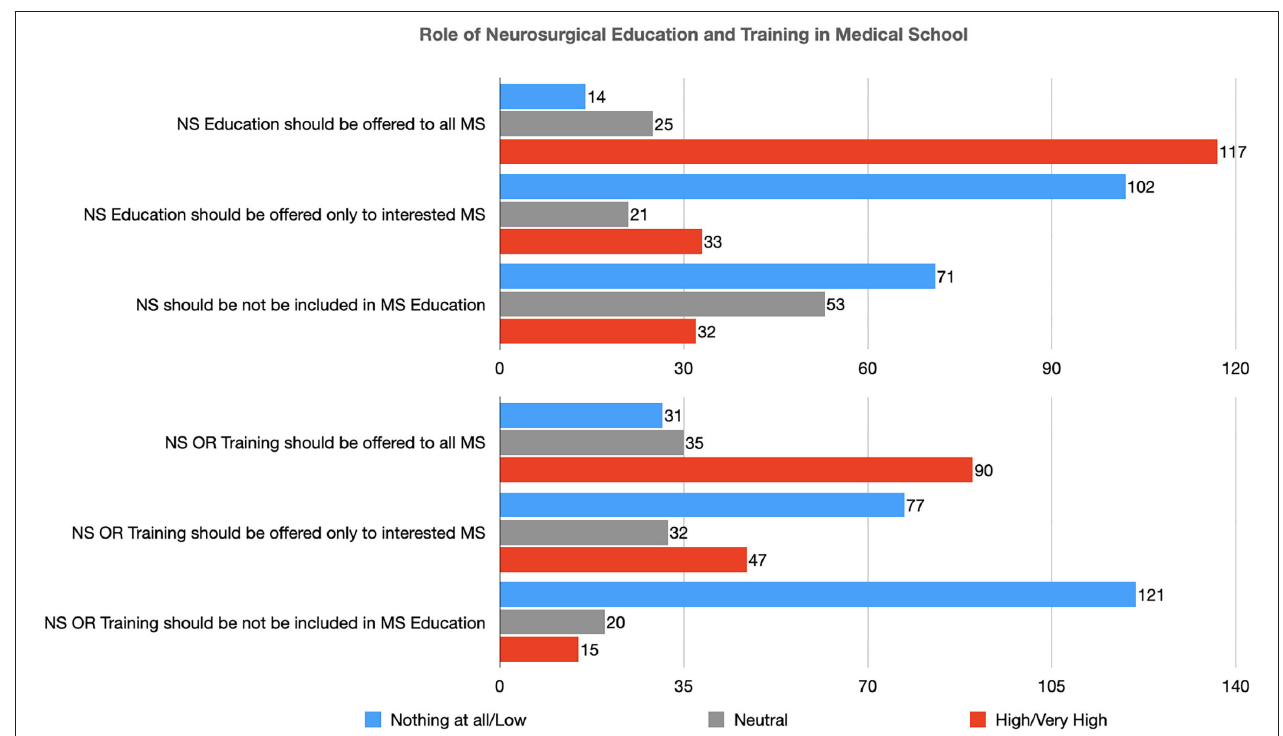
FIGURE 3 | Role of neurosurgical education and training in medical school (NS, Neurosurgery; MS, Medical Student; OR, Operating Room).